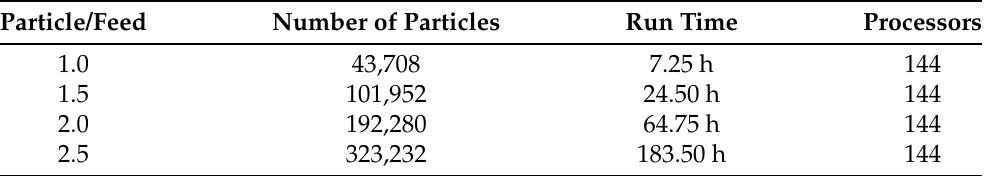
Table 5. Convergence study: Number of SPH particles and the simulation time.